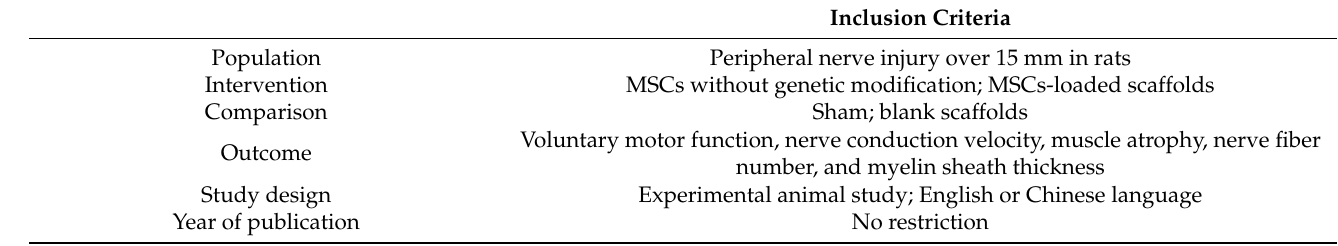
Table 1. Eligibility criteria for study identification according to the PICOS framework. In order to filter out studies eventually impacted by natural regeneration due to a limited gap size, the limit for inclusion was set at 15